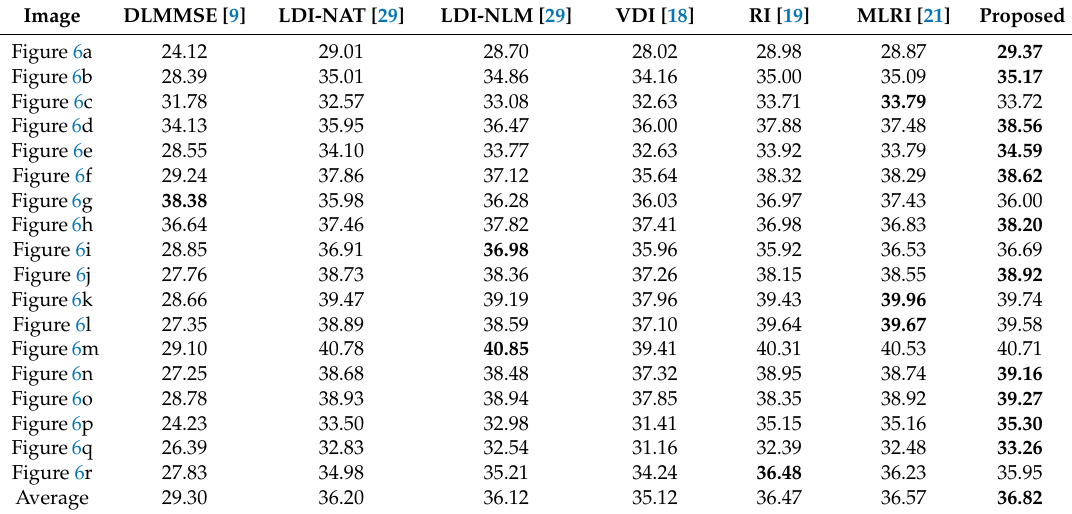
Table 3. The CPSNR (dB) of MCMaster